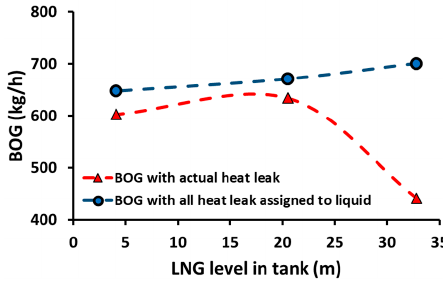
Figure 7. BOG over prediction with heat leak.